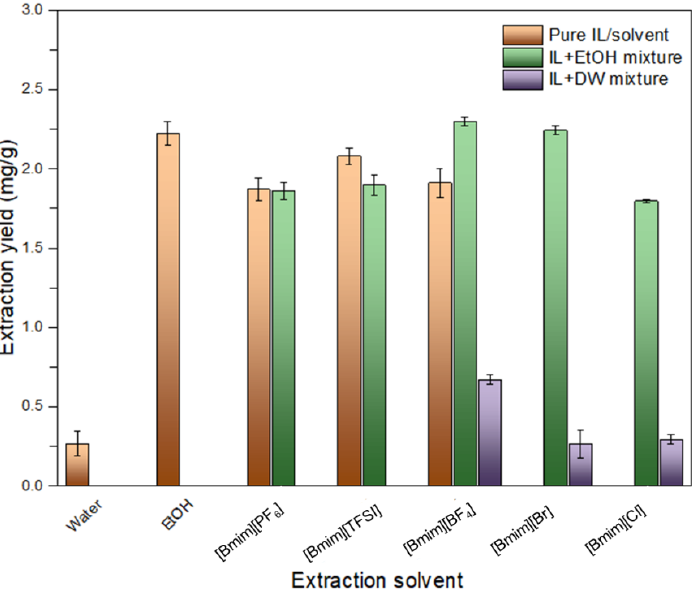
Figure 2. Effect of extraction media on the extraction yield of isoimperatorin.